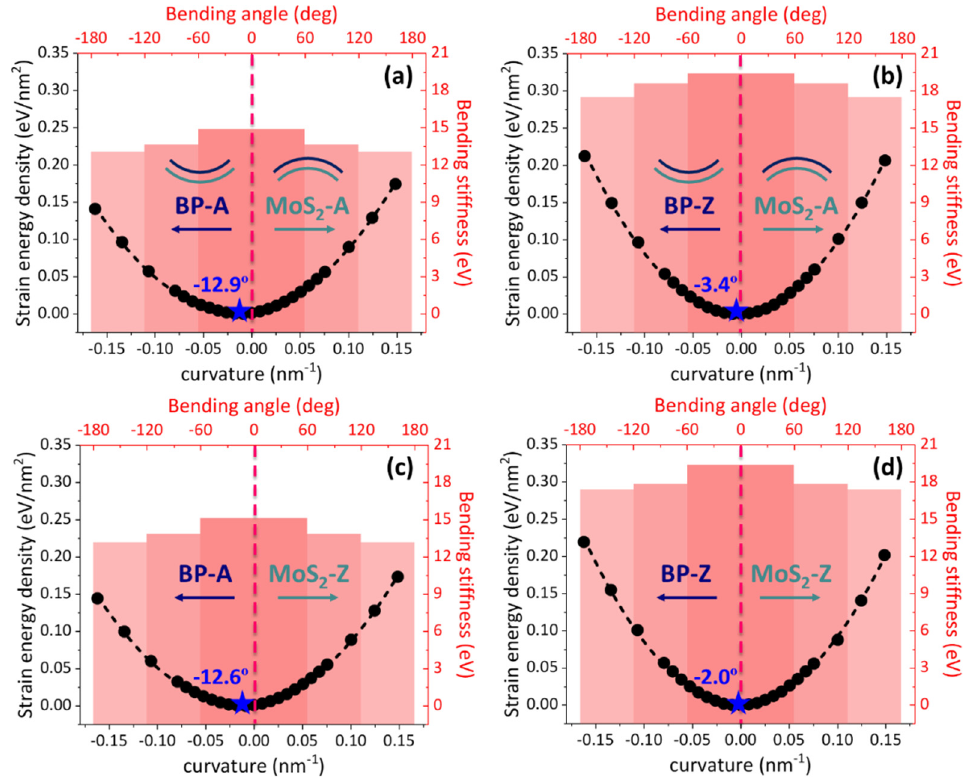
Figure 3. The relationships between the strain energy density and bending stiffness of BP/MoS 2 with four stacking orders versus the curvature (black axis) and bending angle (red axis), respectively. ( a ) BP-A/MoS 2 -A. ( b ) BP-Z/MoS 2 -A. ( c ) BP-A/MoS 2 -Z. ( d ) BP-Z/MoS 2 -Z. The black scatters represent the relation between the strain energy density and curvature, and the black dotted line is the fitting line. The red histograms show the relationship between the bending stiffness and the three ranges of bending angles.